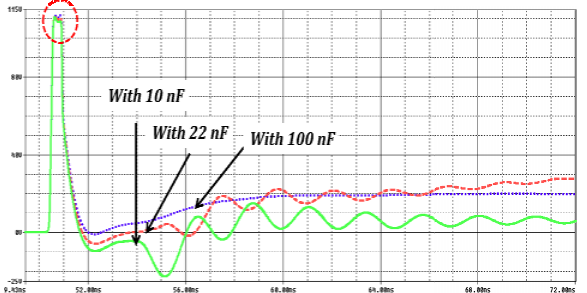
Figure 23: Voltage at IC input during 15 kV ESD pulse applied on IC with 10, 22 or 100 nF capacitor protection.